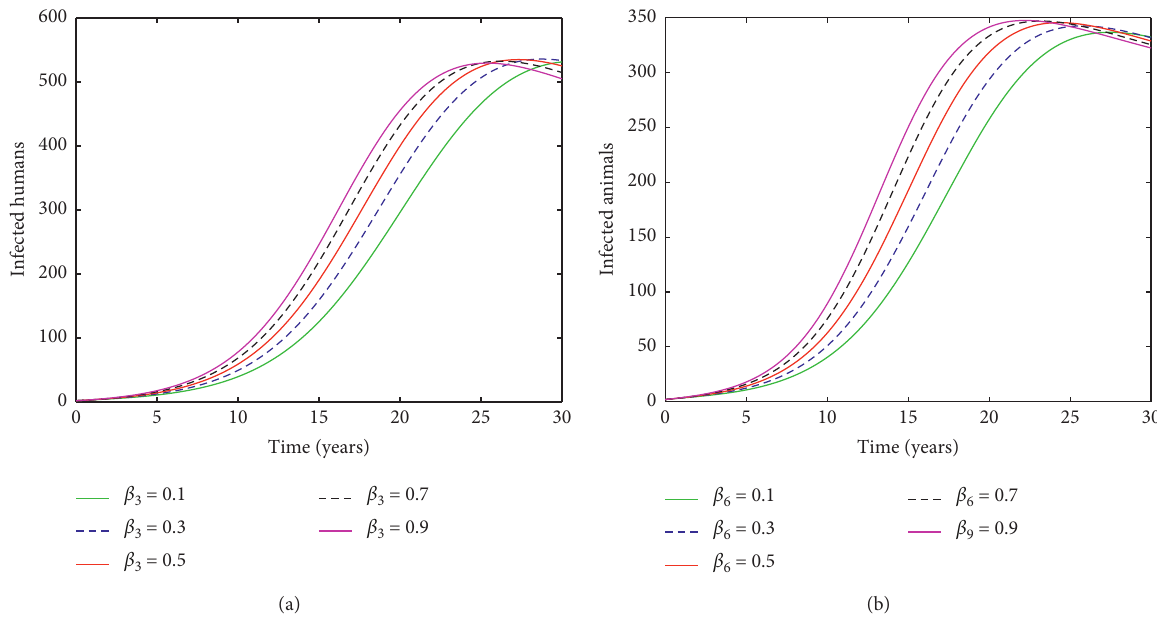
Figure 8: The impact of rates of transmission form dairy products to infected (a) humans and (b)